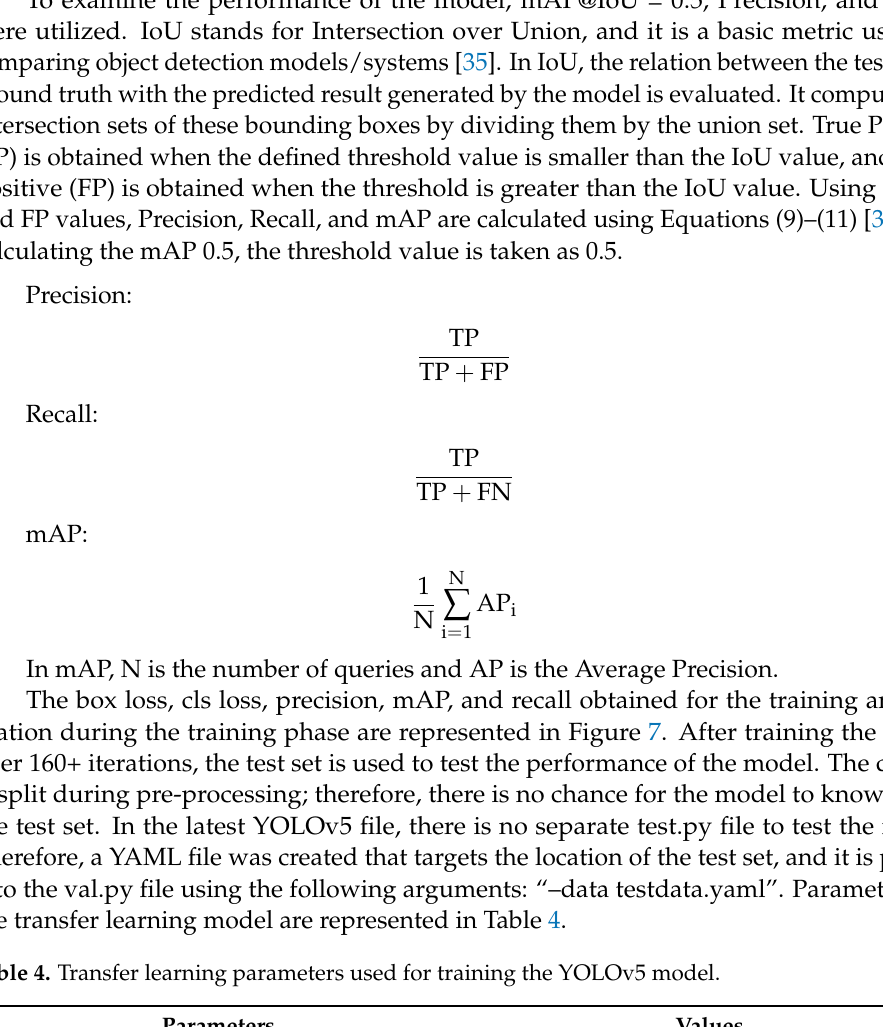
Figure 6. Flow chart for Image Augmentation. Algorithm 1: Localization using YOLOv5